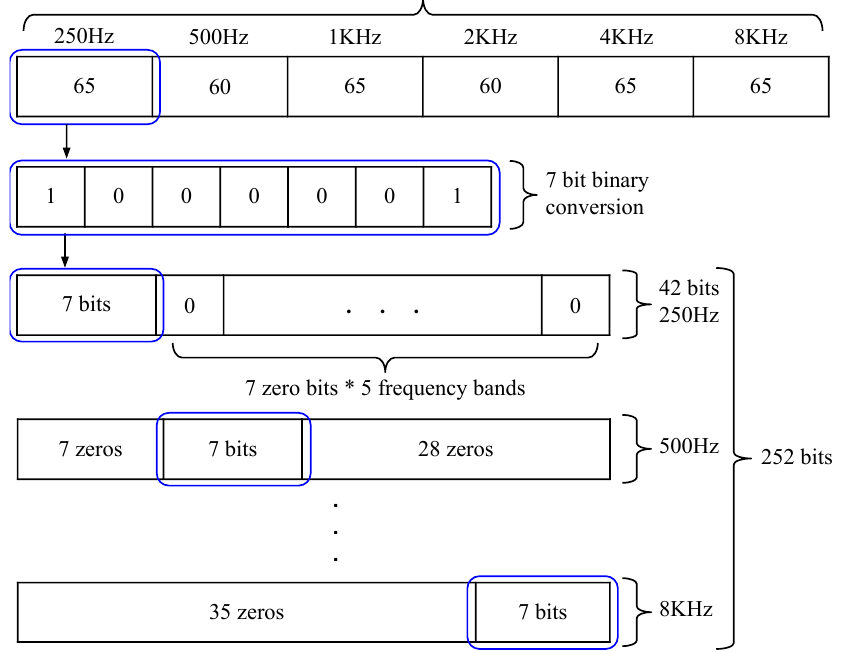
Figure 4. Binary conversions of input